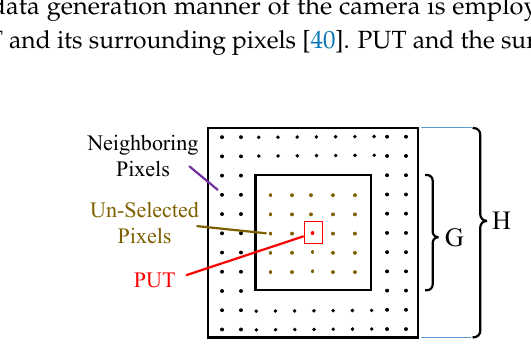
Figure 10. The location relationship between pixel under test (PUT) and surrounding